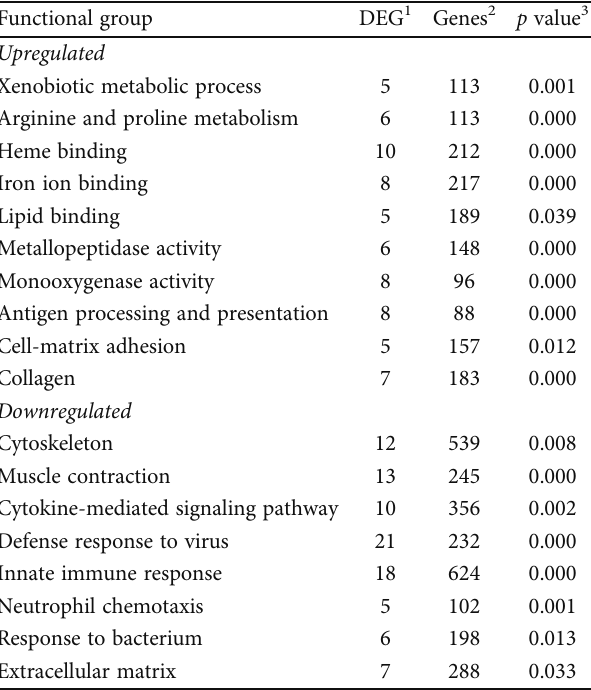
Table 11: Enrichment of functional categories of Gene Ontology among genes that responded to the